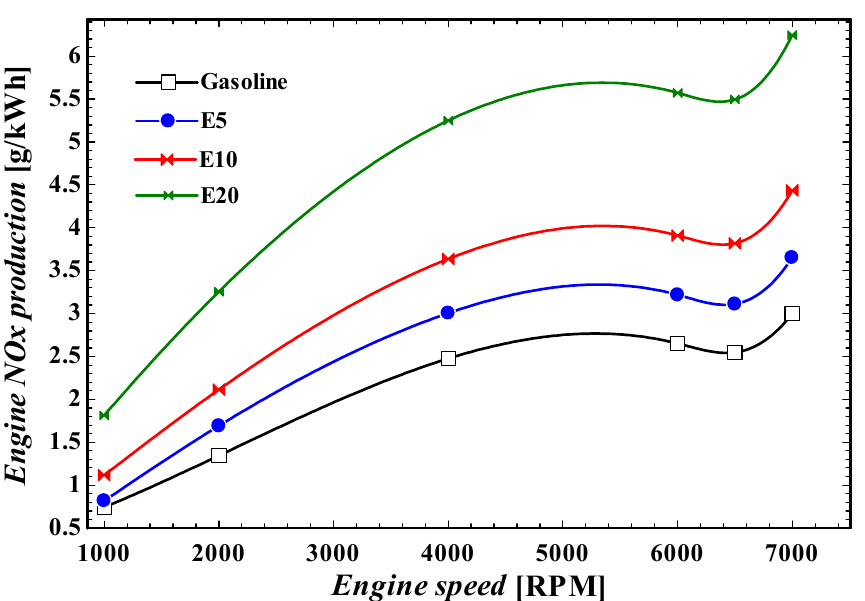
Figure 5. Engine nitrogen oxide production at various engine speeds at different fractions of ethanol.